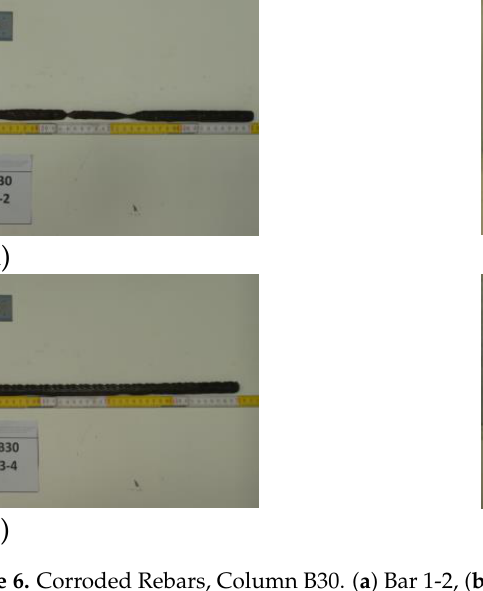
Figure 6. Corroded Rebars, Column B30. ( a ) Bar 1-2, ( b ) Bar 2-3, ( c ) Bar 3-4, ( d ) Bar 4-1.